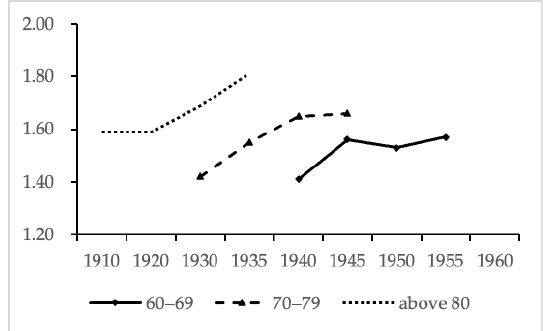
Figure 2. Cohort trends in loneliness by age group.